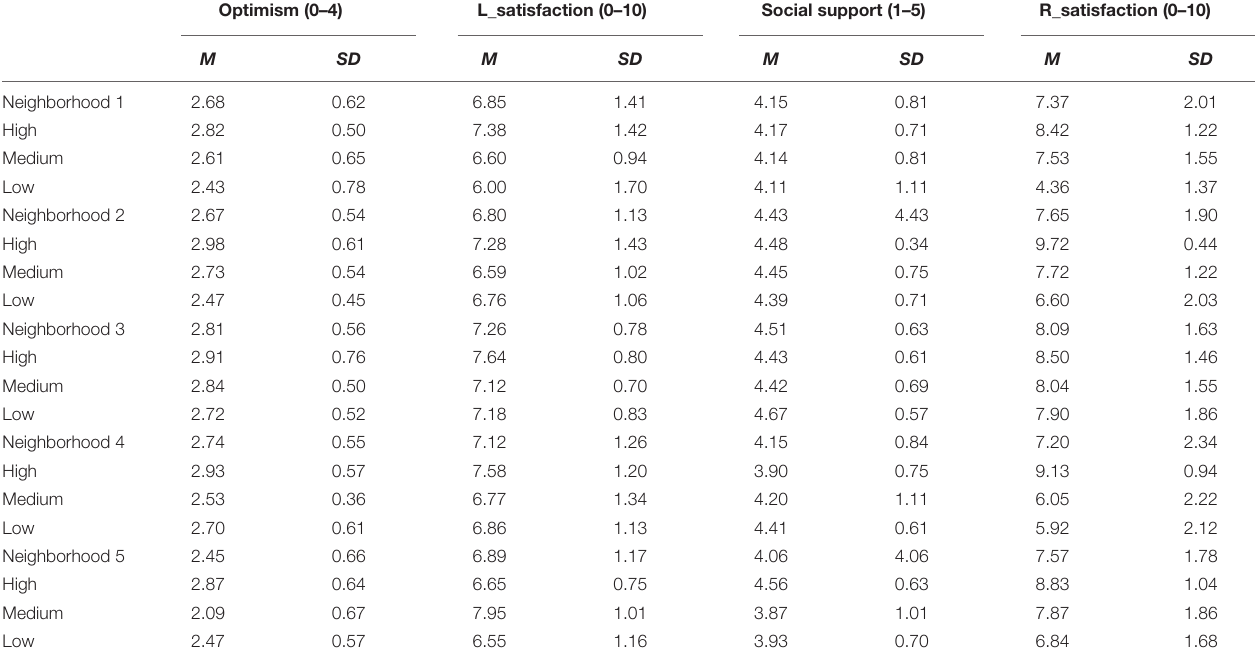
TABLE 4 | Descriptive statistics of dependent variables according to residents’ perception of each